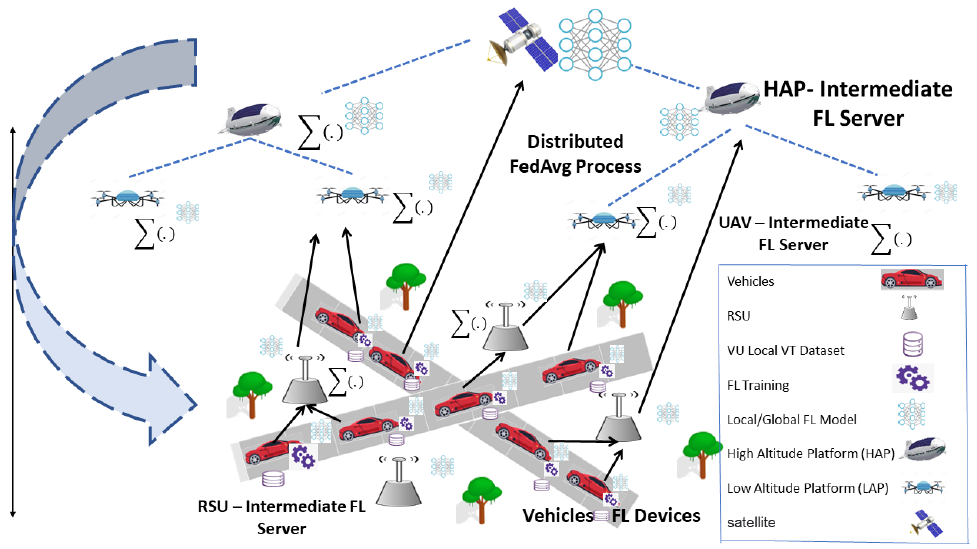
Figure 10. Distributed FL